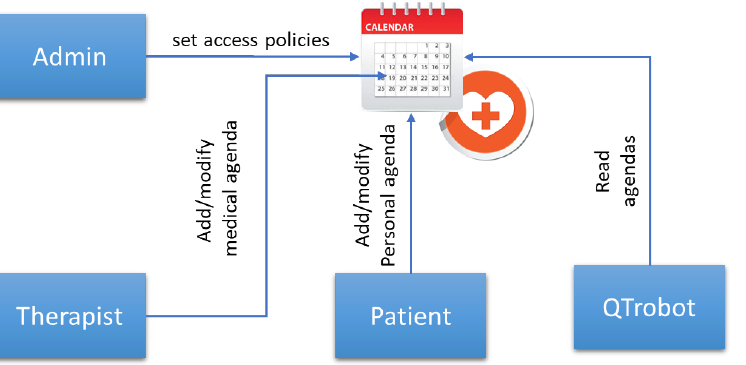
Figure 6. Simplified representation of medical calendar access